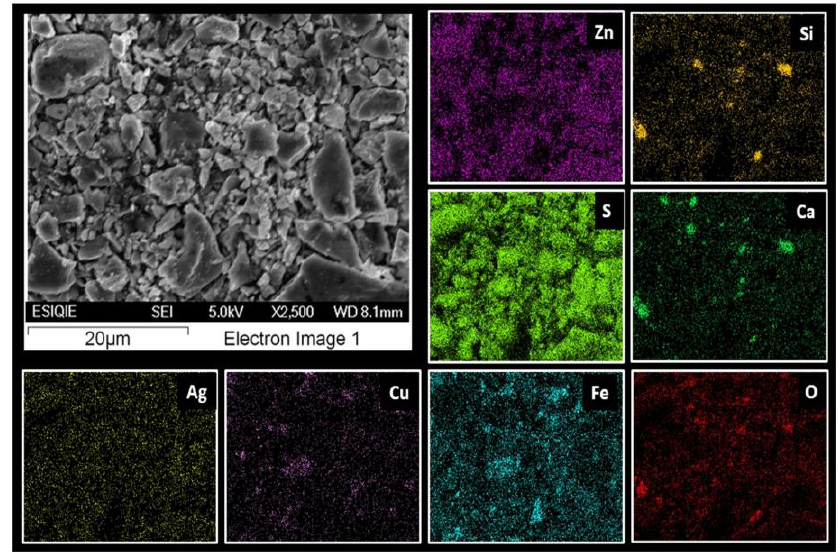
Figure 5. Mapping of concentrate Zn powders.